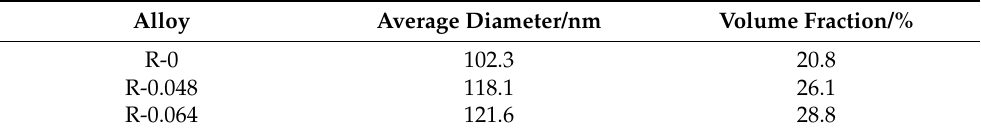
Figure 9. Morphology and distribution of γ ’ in Sc-doped RR1000 after heat treatment. ( a , d , g ) 0 wt.% Sc, ( b , e , h ) 0.048 wt.% Sc, ( c , f , i ) 0.064 wt.% Sc. Table 7. The size and volume fraction of secondary γ (cid:48) in Sc-doped RR1000 after heat